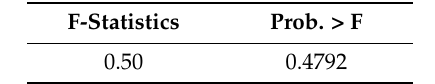
Table A11. Durbin–Wu–Hausman test with Exchange Rate Volatility (GARCH).